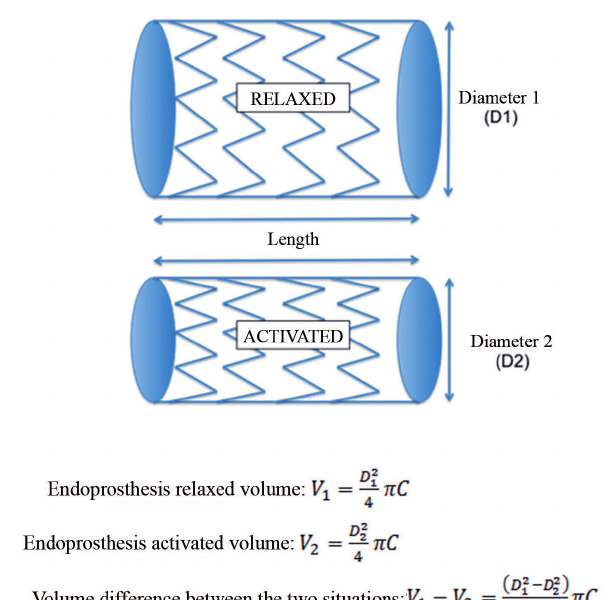
Fig. 1 - Schematic of the variation in volume between the two states of the contractile prosthesis: relaxed and